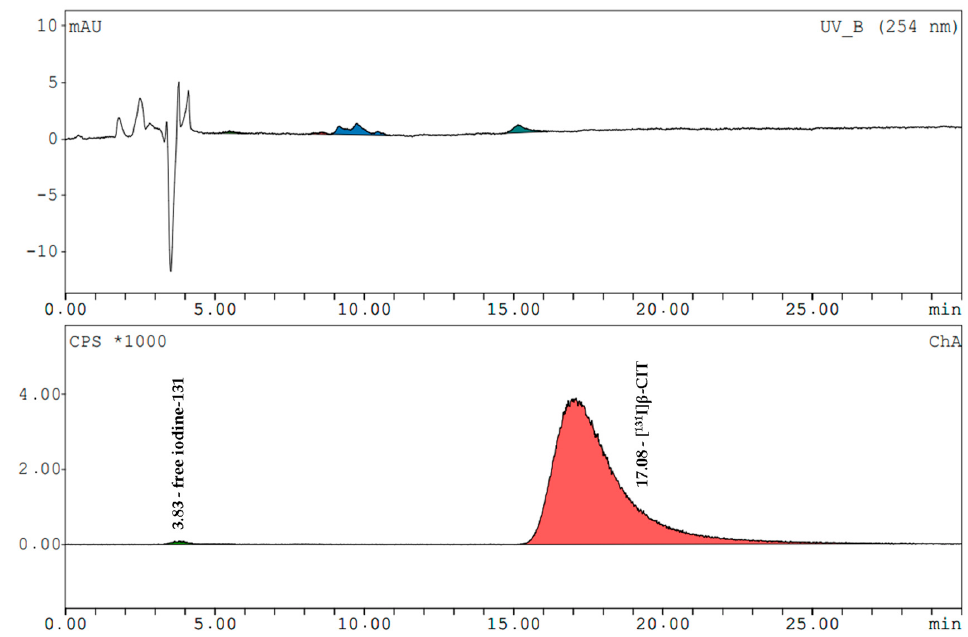
Figure 3. HPLC analysis of a [ 131 I] β -CIT product solution. Upper trace: UV-VIS spectrum, lower trace: radiometric spectrum.